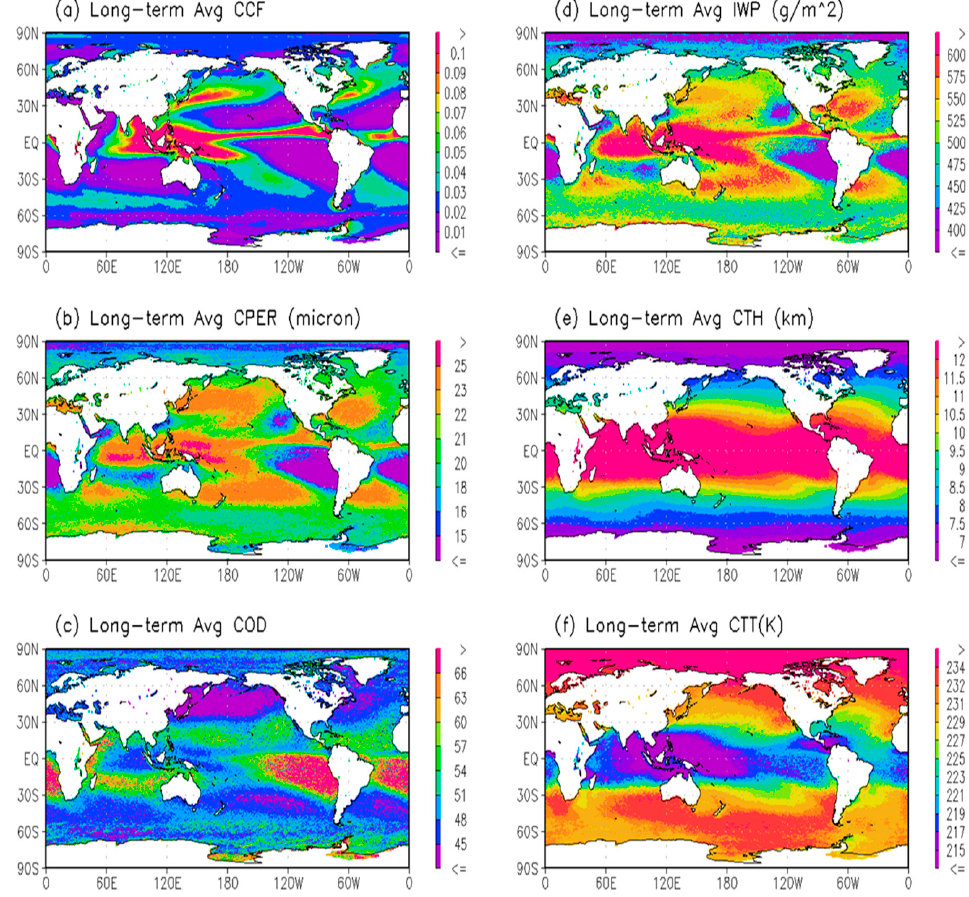
Figure 2. Distributions of six cloud variables ( a ) CCF, ( b ) CPER, ( c ) COD, ( d ) IWP, ( e ) CTH, and ( f ) CTT) of DCC for their long-term averaged monthly mean values over the global oceans.